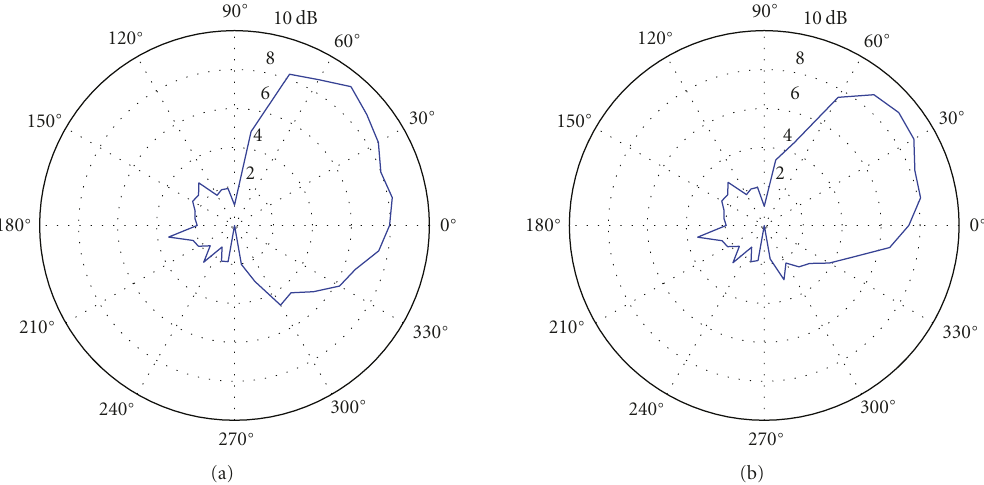
Figure 7: Di ff erent settings of the detection threshold T 1 and their influence on the beam width (delta-delta-algorithm, T 1 = 0 . 1 (wide beam, left) and T 1 = 0 . 4 (narrow beam,